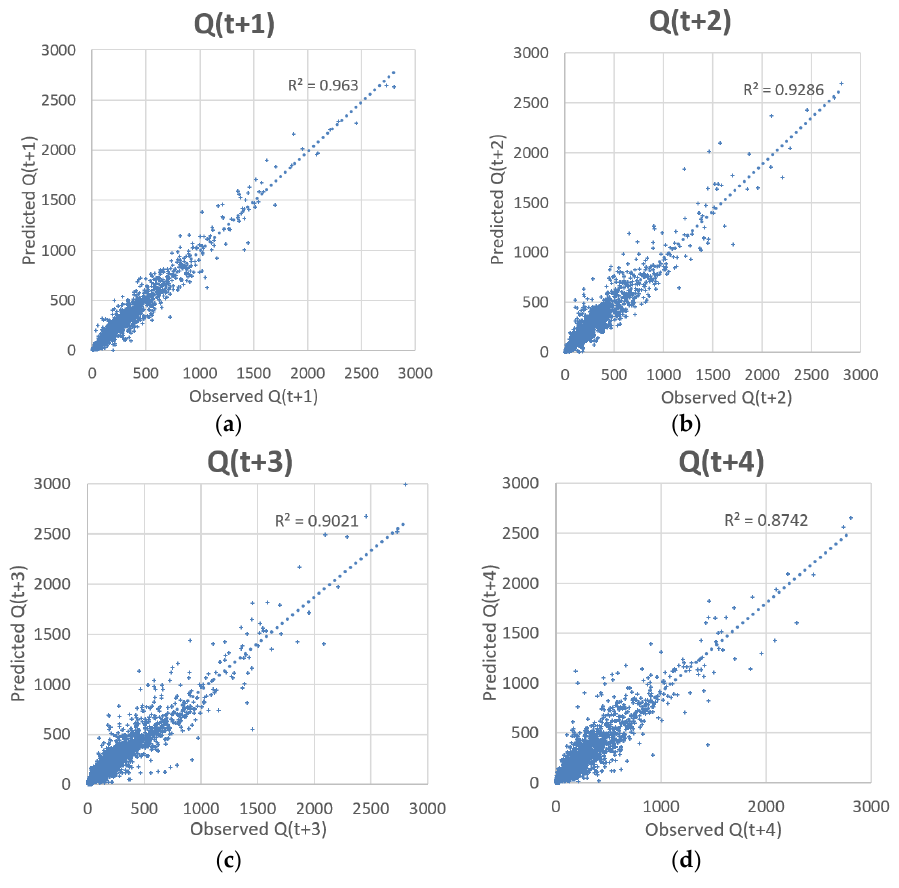
Figure 8. Q( t +3) predicted vs observed for LGP-10 and LGP as a standalone.